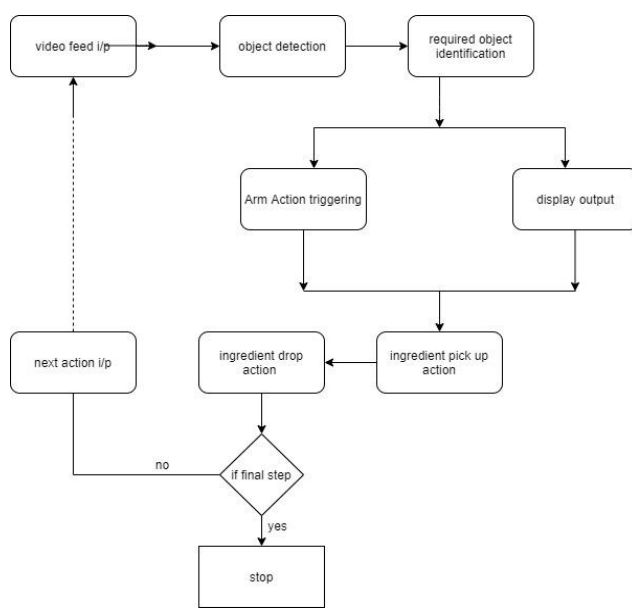
Figure 1. architecture of the proposed